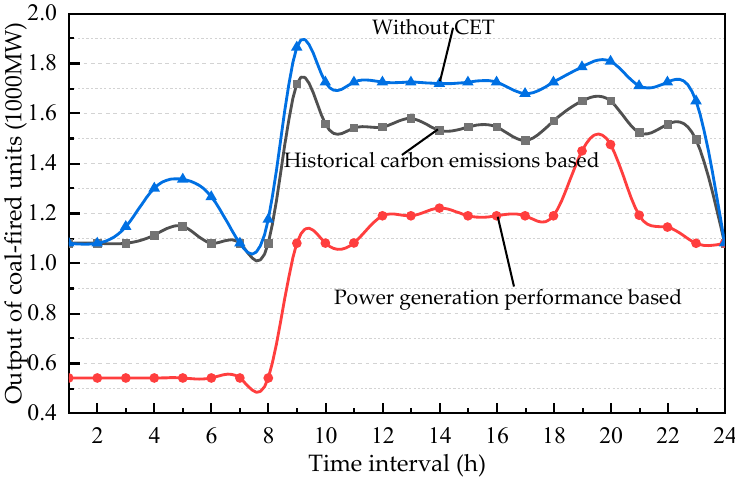
Figure 12. Comparison of outputs of coal-fired units.